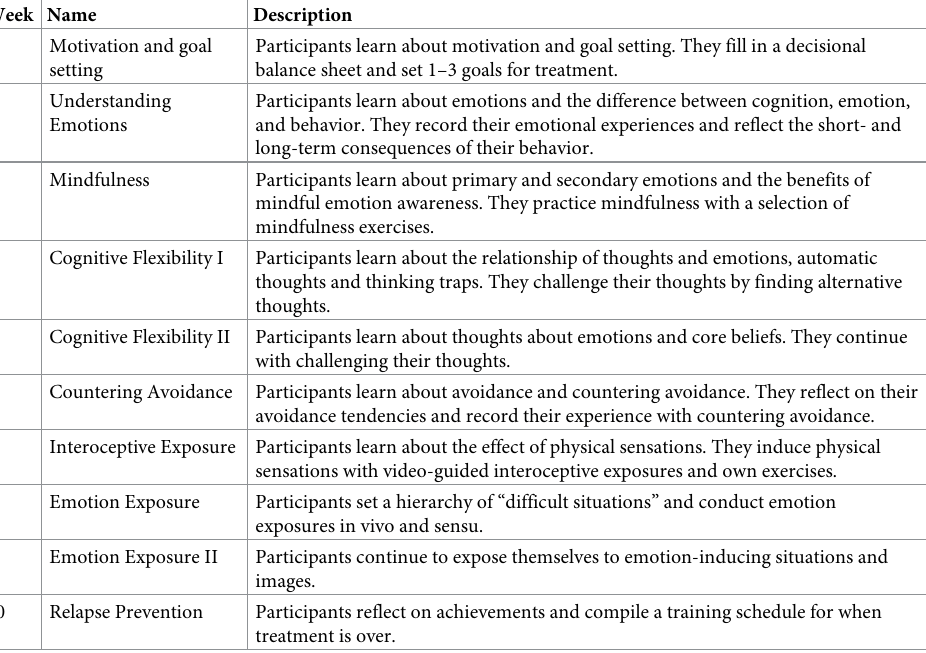
Table 1. Overview of guided